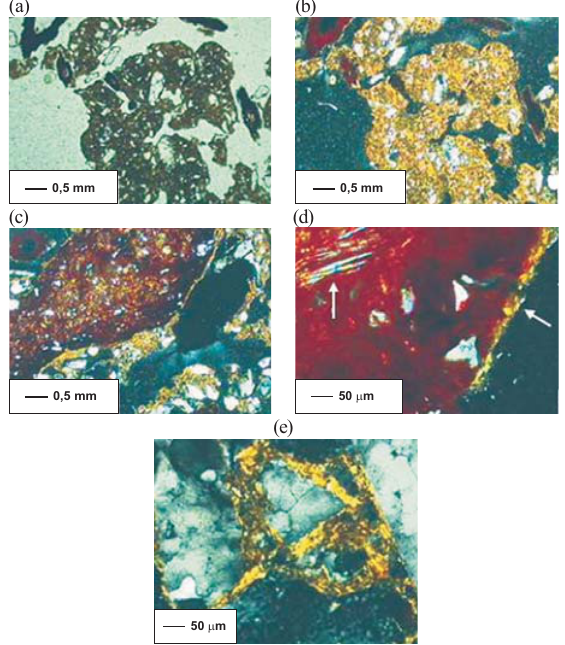
Figura 5. Micrografias do horizonte A do Cambissolo Háplico Tb distrófico típico, leste de Goiás (CX1). (a) espaço entre cascalhos e calhaus, apresentando-se muito poroso (canais e alvéolos), com o pouco plasma de distribuição porfírica relativamente ao esqueleto e com fragmentos de raiz; (b) idem anterior, sob nicóis cruzados; (c) nódulo ferruginoso, quase opaco, revestido por película de material fino (plasma), fragmentos de raiz e canais de atividade biológica; (d) detalhe de nódulo ferruginoso, quase opaco – reparar em cima, à esquerda, minerais aciculares com cores de interferência fortes e, à direita, revestimento de material fino (plasma) (setas indicando); (e) grãos de quartzo do esqueleto revestidos por película de material fino (plasma) [micrografia (a) sob luz polarizada em um plano, sendo as restantes sob nicóis